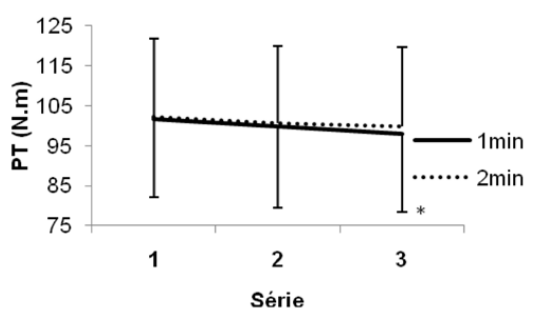
Figura 2. Pico de Torque (PT) a 180°/s nas três séries com um e dois minutos (min) de intervalo de recuperação.* (p < 0,05) menor que a 1ª série.